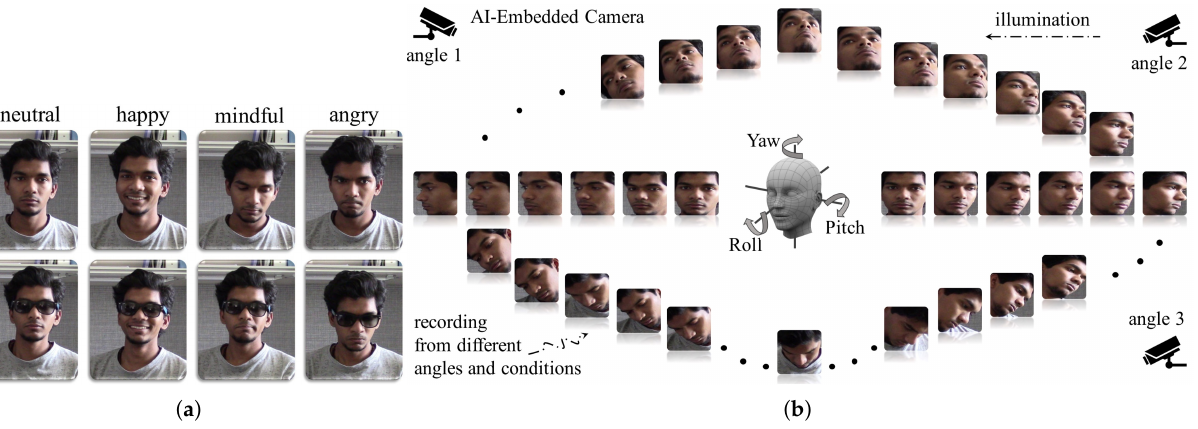
Figure 7. We structure and train our model to be robust to variance in pose, lighting, and occlusion. Occlusions and expressions are illustrated in ( a ), and different Yaw, Pitch, and Roll variations are illustrated in ( b ).